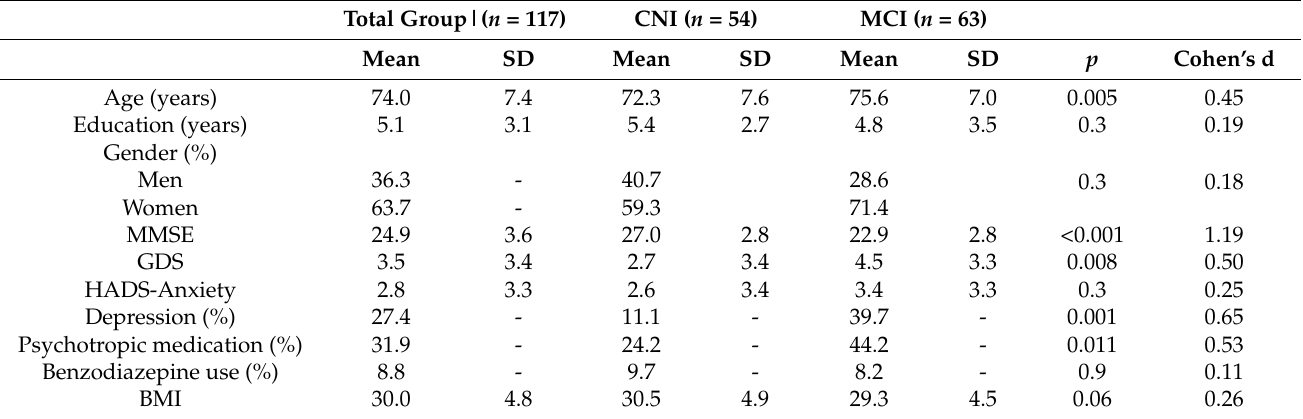
Table 1. Demographic and clinical parameters of the total sample and by diagnostic group.